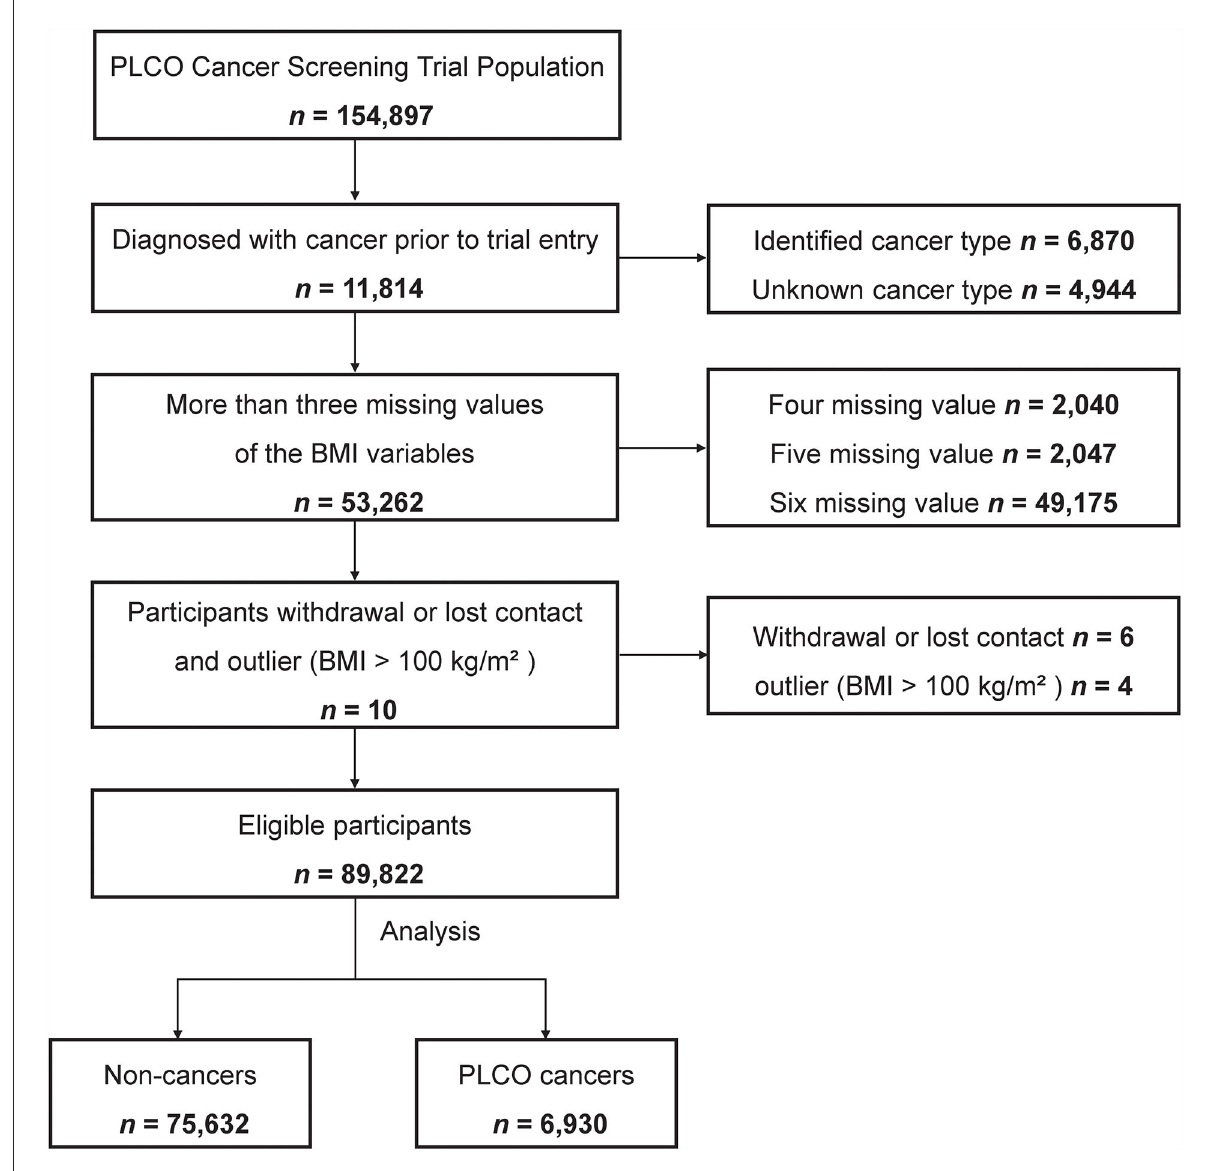
FIGURE1 Flowchart of inclusion